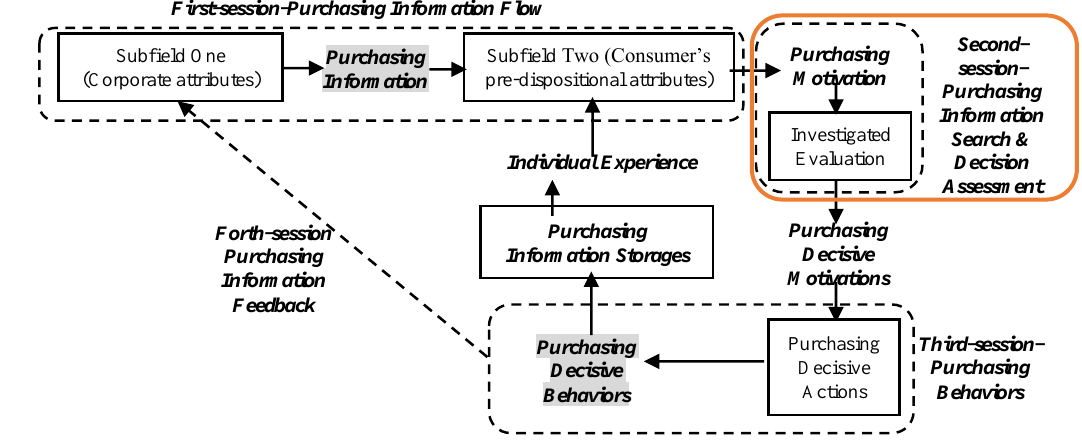
Figure 5. Basic analytical structure in purchasing procedure in NI mode.